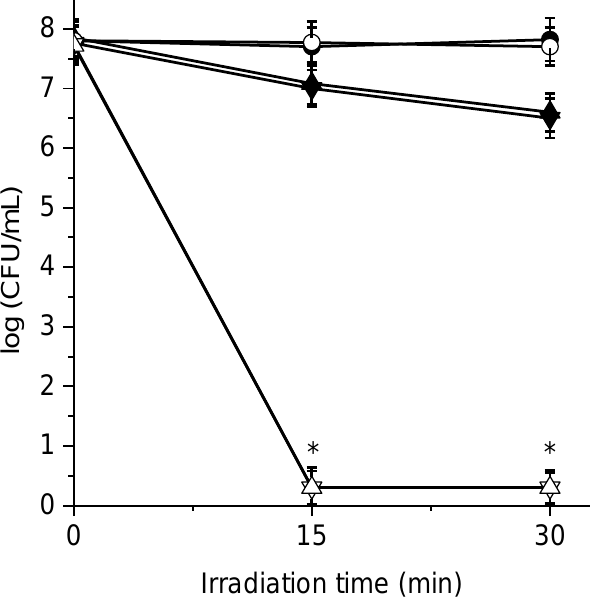
Figure 6. Survival of S. aureus (~10 7 CFU/mL) treated with 0.5 µ M ( (cid:72) ) PTPPF 16 -EDA and ( (cid:78) ) PZnTPPF 16 -EDA for 30 min at 37 ◦ C in the dark and irradiated with white light (90 mW/cm 2 ) for different times. Irradiated control: culture without PS ( • ) (* p < 0.05 compared with control).